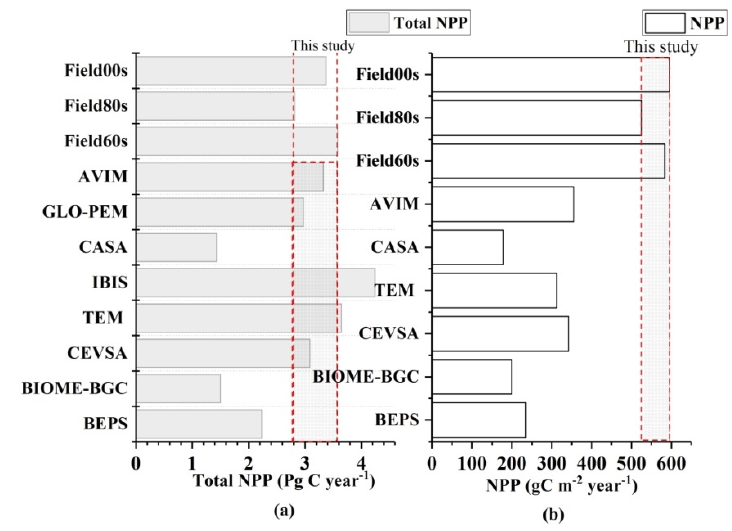
Figure 7. Research results of China’s vegetation total and average NPP from the 1960s to the 2000s: ( a ) total NPP; and ( b ) average NPP.